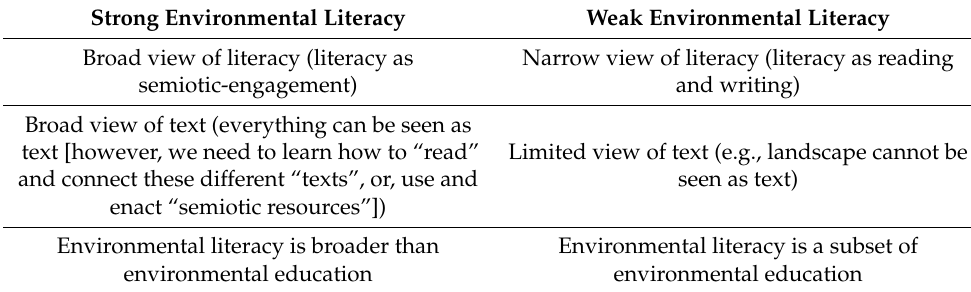
Table 1. Strong-weak environmental literacy distinction (adapted from [6], see p. 94). Strong Environmental Literacy Weak Environmental Literacy Broad view of literacy (literacy as Narrow view of literacy (literacy as reading semiotic-engagement) and writing) Broad view of text (everything can be seen as text [however, we need to learn how to “read” Limited view of text (e.g., landscape cannot be seen as text) and connect these different “texts”, or, use and enact “semiotic resources”]) Environmental literacy is broader than Environmental literacy is a subset of environmental education environmental